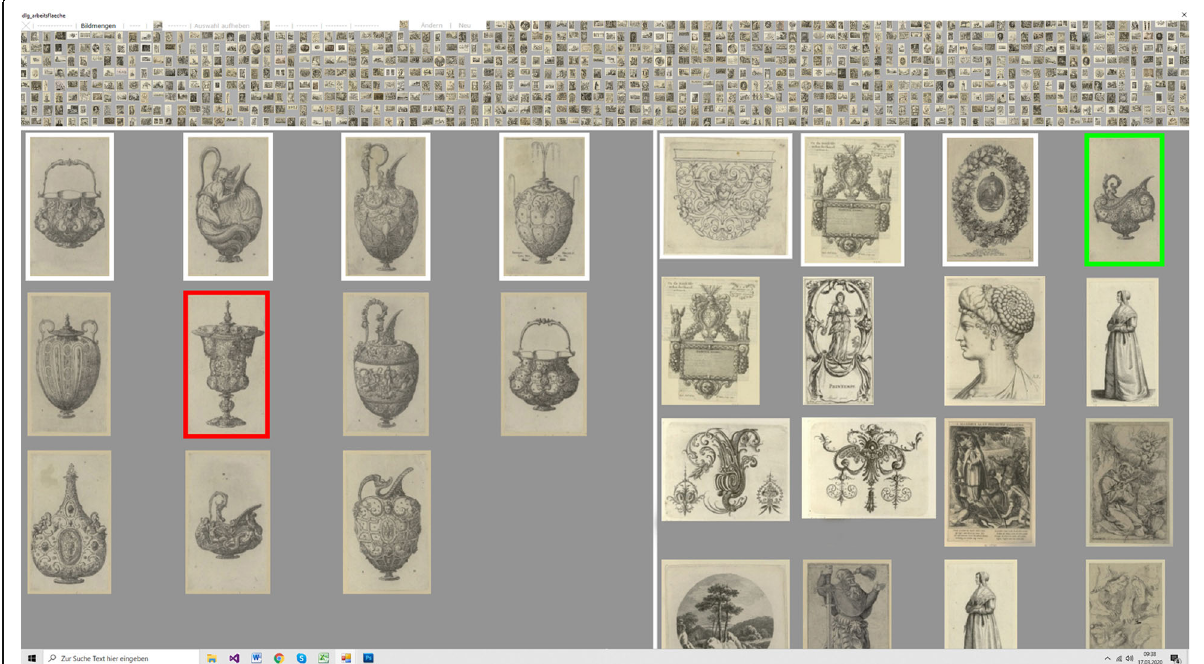
Fig. 7 Interface for correcting a LadeCA word